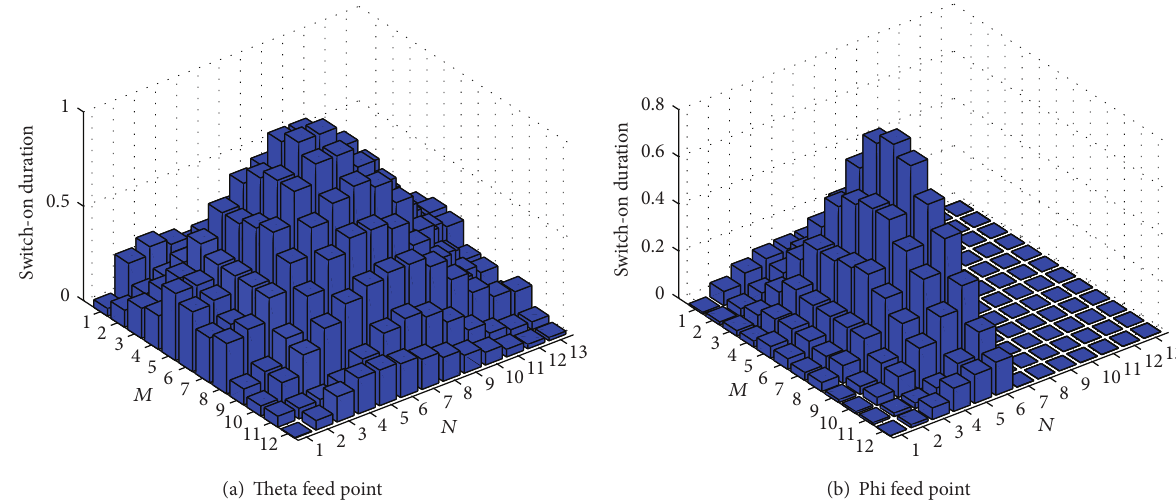
Figure 14: Optimized switch-on durations in the theta feed point and phi feed point for scan direction of (45 ∘ ,0 ∘ ) for solution A in Figure 7.